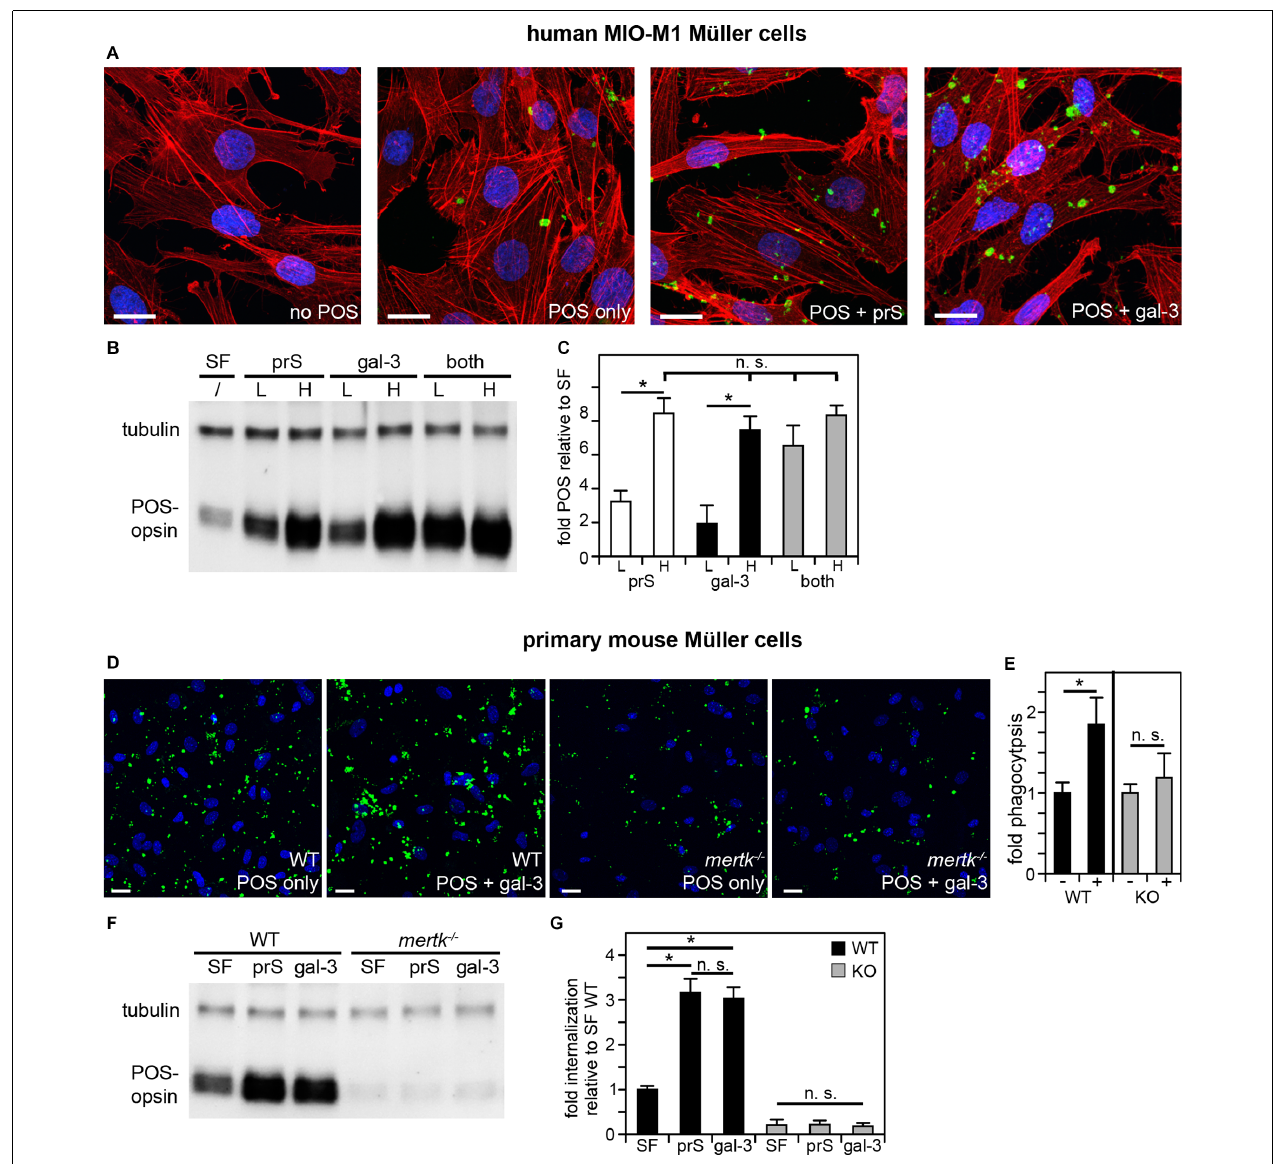
FIGURE 1 | Müller cells in culture phagocytose in a MERTK-dependent manner using either protein S or galectin-3 as MERTK ligands. POS phagocytosis assays explored immortalized human MIO-M1 Müller cells (A–C) or primary mouse Müller cells (D–G) in culture followed by immunofluorescence microscopy or lysis and immunoblotting. (A–C) Human MIO-M1 Müller cells were challenged with fluorescent POS in serum-free medium with or without added MERTK ligands at high concentration (2 µ g/ml) for microscopy (A) or at high concentration (H) or low concentration (L, 0.4 µ g.ml) as indicated for immunoblotting (B,C) . Combination treatments were a mix of both ligands with both at low or high concentration. Representative maximal projections in (A) show POS (green) and F-actin (red) and nuclei (blue). Scale bars: 20 µ m. A representative immunoblot membrane is shown in (B) directly comparing POS uptake indicated by levels of the POS marker protein rhodopsin relative to tubulin, which was used as sample loading control. Bars in (C) show quantification of blot results as in (B) to directly compare levels of phagocytosed POS in each condition. Bars show mean ± s. d.; n = 4 independent experiments. ANOVA post-hoc test revealed differences as indicated (n. s., not significant; * p < 0.05). ANOVA also revealed significant differences ( p < 0.05) to cells without added ligands for all single and combined ligand conditions; these differences are not indicated in the bar graph to maintain clarity. (D) WT or mertk -/- (KO) mouse Müller cells in primary culture were challenged with fluorescent POS in serum-free medium with or without added MERTK ligands as indicated followed by fluorescence microscopy analysis. Representative maximal projections in (D) show POS (green) and nuclei (blue). Scale bars: 20 µ m. Bars in (E) show quantification of total POS uptake from data as in (D) . Bars show the comparison of cells receiving galectin-3 (+) compared to the same cells receiving POS alone (-), which are set as 1 for each genotype; mean ± s. d.; n = 3 independent experiments per genotype. Data were analyzed by cell type using Student’s t -test; * indicates p < 0.05. Panel (F) shows a representative immunoblot membrane of phagocytosis assays [assays performed as in (D) ] followed by 2 mM EDTA in PBS wash to remove unengulfed, surface-bound POS prior to cell lysis to allow measurement of internalized POS. Blots were probed for the POS marker rhodopsin and for tubulin, which was used as sample loading control. Bars in (G) show quantification of blot results as in (F) comparing levels of internalized POS normalized to tubulin among samples. Bars show mean ± s. d.; n = 3 independent experiments. ANOVA post-hoc test revealed significant effects of protein S and galectin-3 on WT Müller cell but not mertk -/- Müller cell internalization as indicated; (n. s., not significant; * p < 0.05). Additionally and not indicated in the figure, mertk -/- internalization was significantly lower than WT internalization regardless of ligand addition ( p < 0.05).